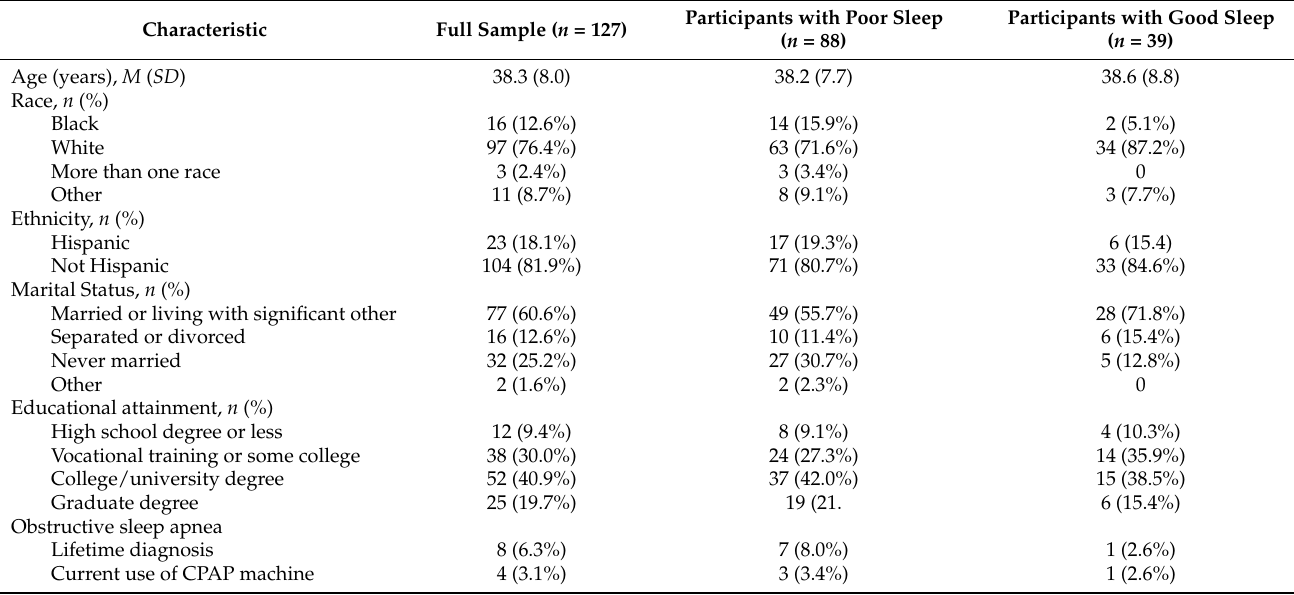
Table 1. Participant